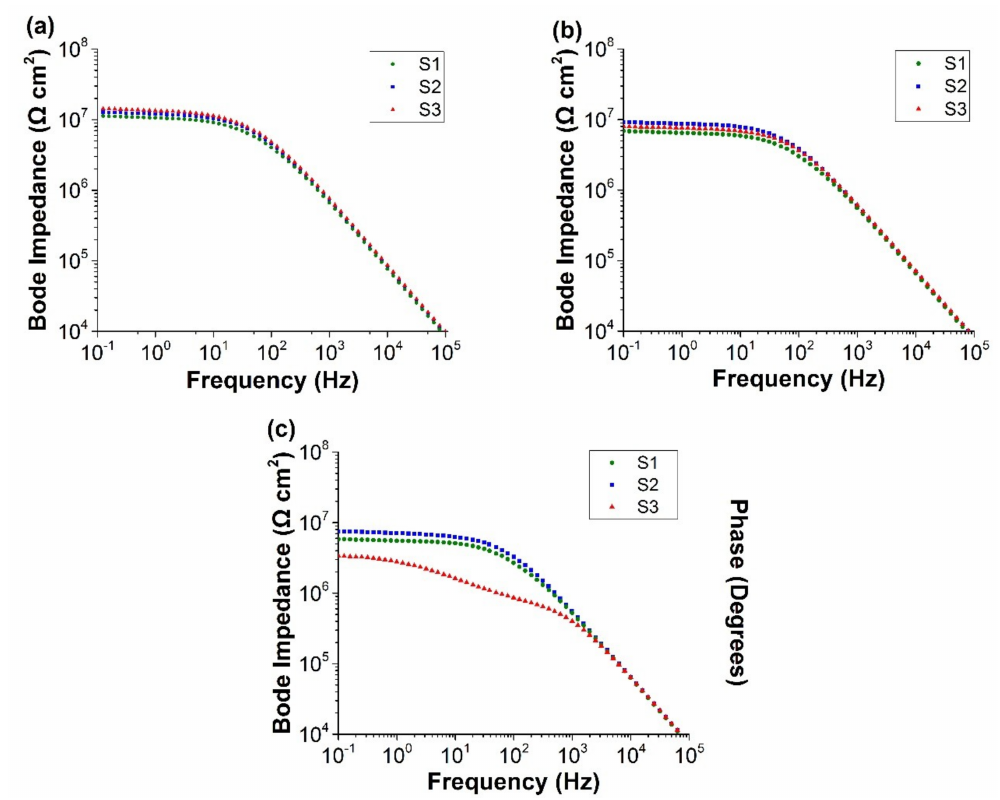
Figure 4. Bode plots of the three different coating systems after; ( a ) 1 h immersion, ( b ) 10 h immersion, and ( c ) 20 h immersion in 0.1 wt.% NaCl